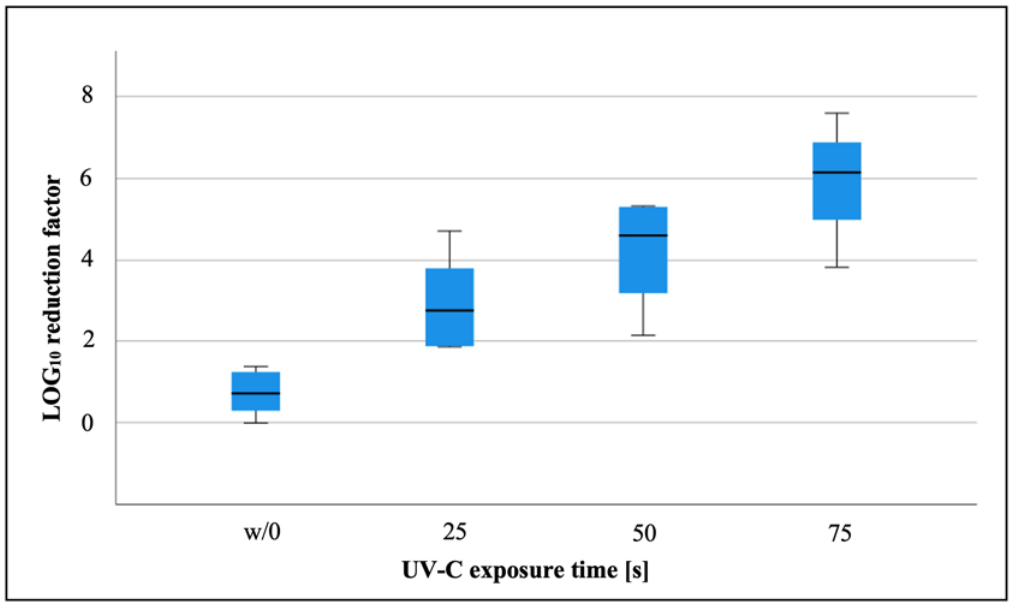
Figure 4. LOG 10 reduction factor (LRF 10 ) of the MS-2 bacteriophages in relation to the UV-C light exposure time in seconds (showing median values, interquartile range, minimum, and maximum). w/0= unirradiated control sample.